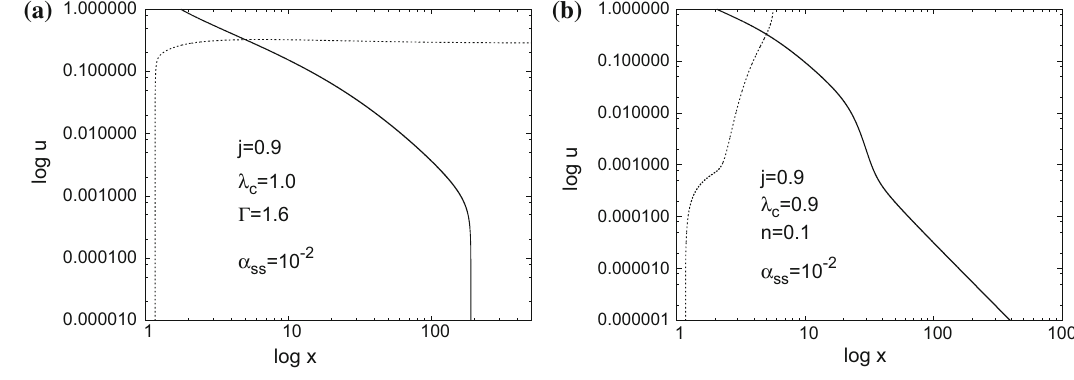
Fig. 9 a , b are plots of log( u ) vs. log( x ) for viscous ( α ss = 10 − 2 ) accretion disc flow around a rotating BH (with specific angular velocity j = 0 . 9) for adiabatic and MCG cases, respectively. Accretion and wind curves are depicted by solid and dotted lines, respectively